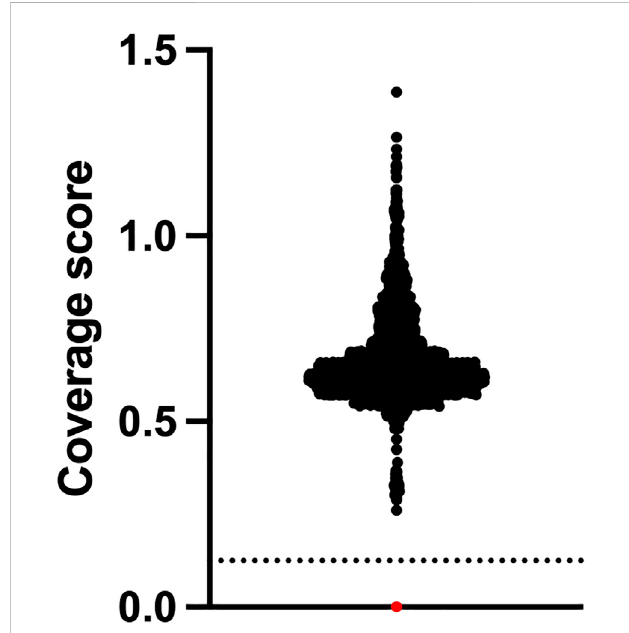
FIGURE 2 SMAnewbornscreeningusingNGShas100%speci fi city.Newborns ( n = 2,552) who were clinically unaffected by SMA at approximately 18 months of age underwent NGS of the SMN1 gene and relative copy number analysis of exon 7 which is expressed as a coverage score per sample. Positive samples have a homozygous exon 7 deletion and are found below the dotted line cut-off value. Black dots are negative samples. The red dot is a Coriell SMA positive control sample